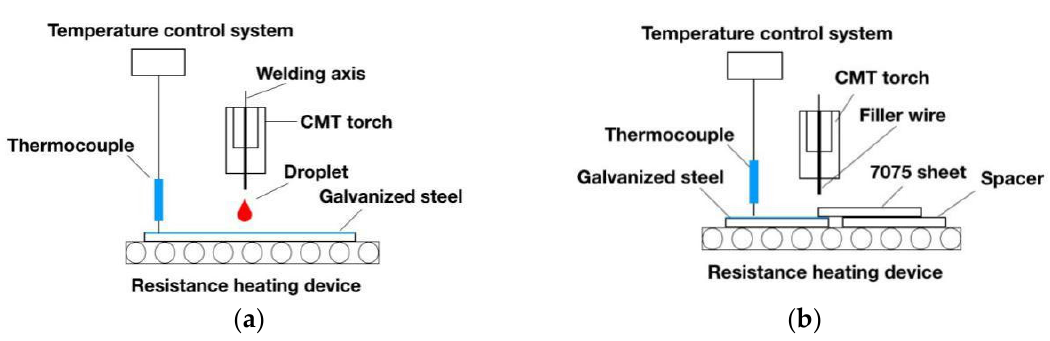
Figure 2. Schematic of CMT joints. ( a ) Bead-on-plate CMT brazing; ( b ) overlap CMT welding–brazing.